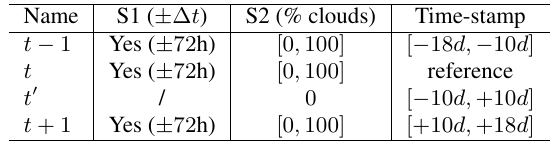
Table 5. Acquisitions layout used to train the MSOP unet